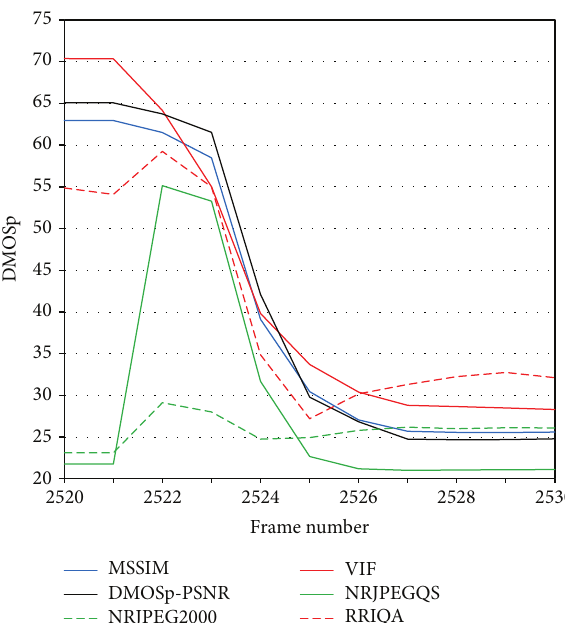
Figure 12: End of the large burst for the low compression panel. FR and NR metrics show the opposite behavior.